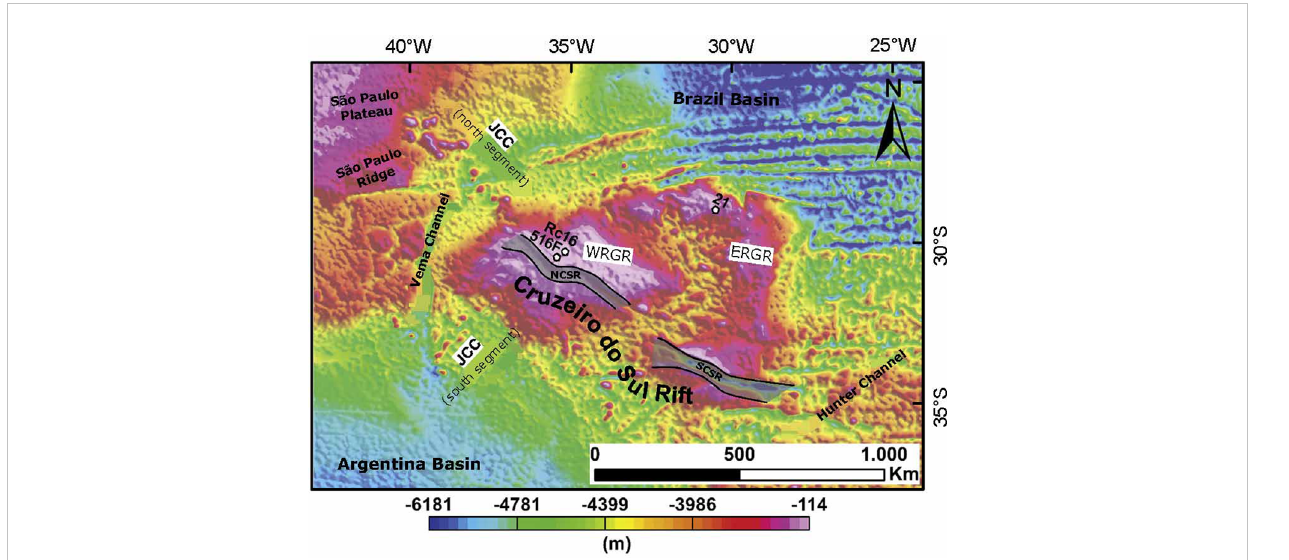
FIGURE 3 Bathymetric map displaying the Rio Grande Rise and the Cruzeiro do Sul Rift, including the 516F and 21 boreholes and the RC16 Seamount Dredging. WRGR corresponds to the Western Rio Grande Rise, ERGR is the Eastern Rio Grande Rise, JCC is the Jean Charcot Seamounts, NCSR is the northern segment, and SCSR is the southern segment of the Cruzeiro do Sul Rift (extracted from Galvão and De Castro, 2017).